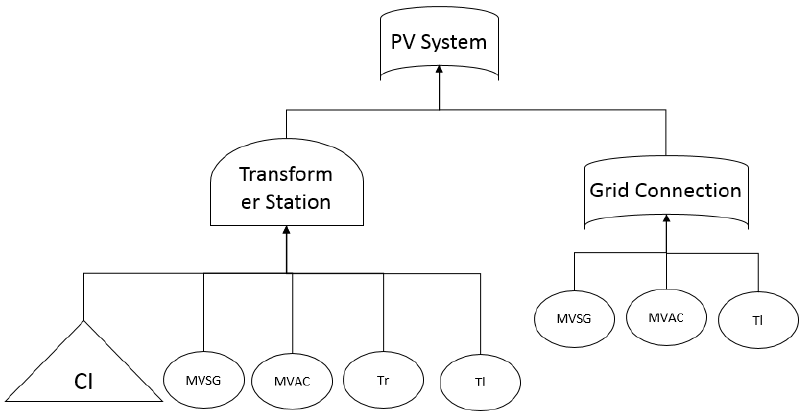
Figure 1. Fault tree for the central inverter (CI) PV system. CI is depicted with the transfer gate symbol (triangle) because this subsystem is shown in another fault tree model.